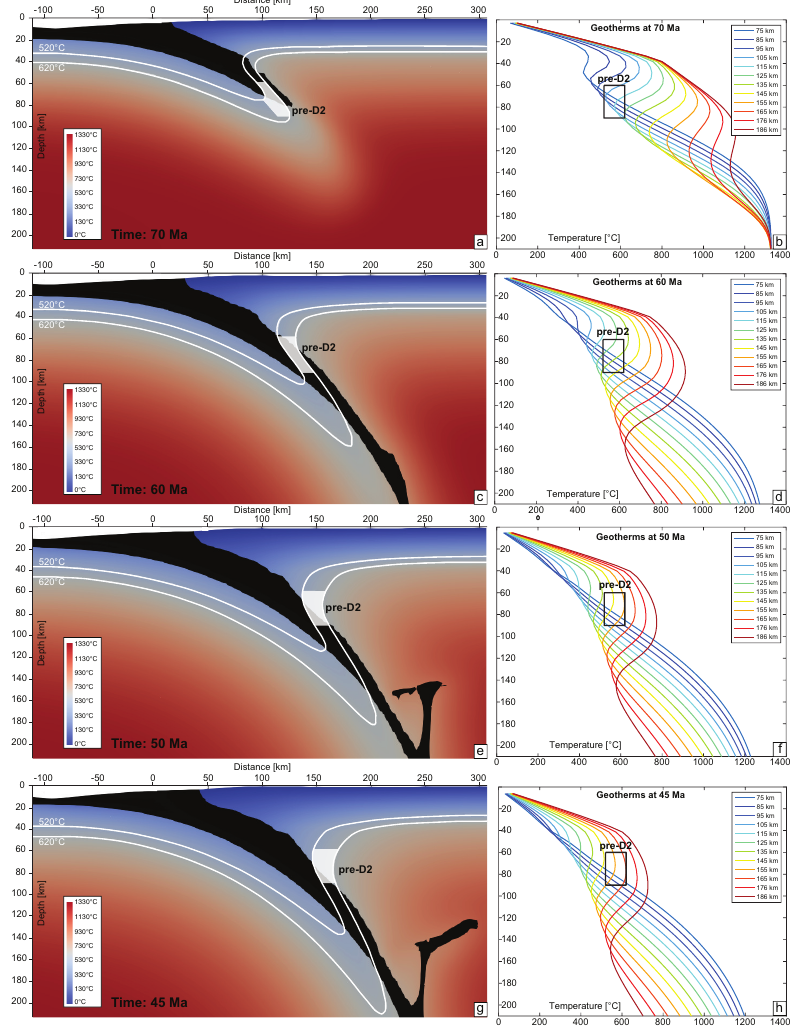
Figure 11. Results of the simulation represented by tectonic setting ( a,c,e,g ) and related geotherms extrapolated at different distances from the trench ( b,d,f,h ) at 70 Ma ( a,b ), 60 Ma ( c,d ), 50 Ma ( e,f ) and 45 Ma ( g,h ). Black color represents the oceanic crust. White isotherms represent the temperature range inferred for the peak conditions of Gias Vej serpentinites (pre-D2). The PT peak conditions are represented by white shaded areas (left) and black box (right). A good agreement is obtained for the comparison at 60 Ma ( c ), where almost the entire upper oceanic crust and part of the lower crust fit the PT conditions of Gias Vej serpentinites, and at 50 Ma ( e ), where most of the upper oceanic crust reaches a thermal state compatible with that of the peak conditions of Gias Vej serpentinites. The peak conditions in the subduction system are achieved at a distance of 115–145 km from the trench and at ca. 60–90 km depth for the stage at 60 Ma ( d ), and at a distance of 135–160 km from the trench and at ca. 70–90 km depth for the stage at 50 Ma ( f